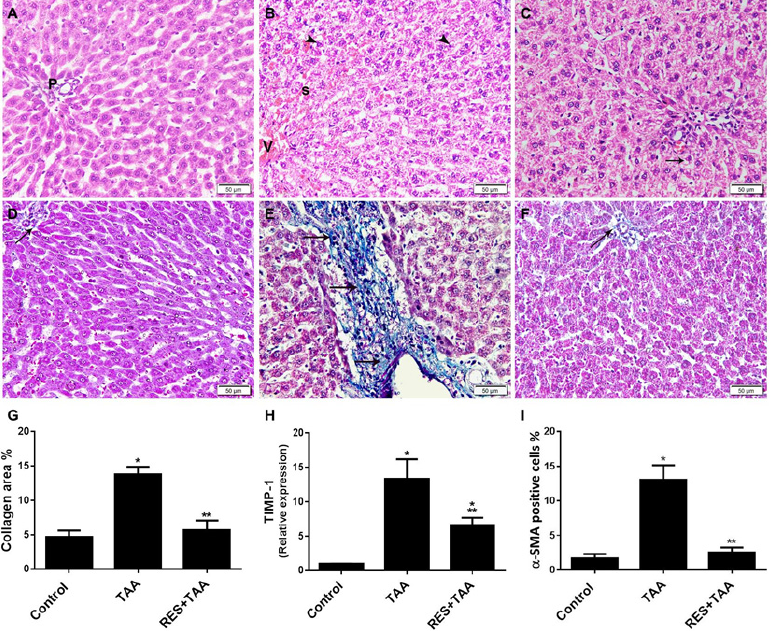
Figure 3. Induction of liver injury and fibrosis by TAA appears to be ameliorated by resveratrol (RES). ( A – C ) H&E-stained images (×200) of liver sections across all rat groups, i.e., control ( A ), TAA ( B ), and RES + TAA ( C ), are displayed. ( D – F ) Images (×200) of Masson’s trichrome stained liver sections across all rat groups, i.e., control ( D ), TAA ( E ), and RES + TAA ( F ), are displayed. In ( D , F ), the arrow points to the thin collagen fibres in the portal area, whereas in ( E ), arrows point to the thick collagen fibres deposit in the portal area and septum. The histograms in ( G – I ) provide a quan- titative analysis of liver fibrosis calculated as the percentage of collagen deposition determined from Masson’s trichrome stain ( G ), TIMP-1 relative gene expression ( H ), and a-SMA protein expression ( I ). * p < 0.001 versus control, ** p < 0.0001versus TAA. TIMP-1: tissue inhibitor of metalloproteinases- 1; TAA: thioacetamide; α -SMA: alpha smooth muscle actin.